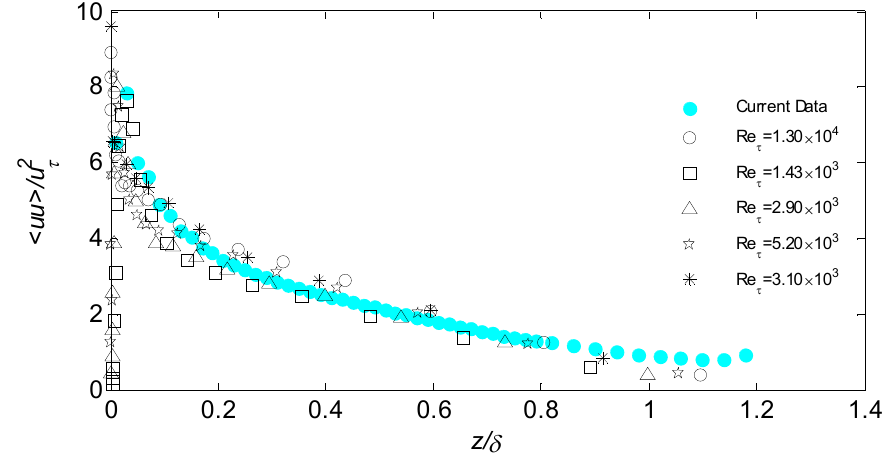
Figure 7. Comparison of uu / u 2 τ in the results of outer-scaled height simulation with the experimental data. The symbols used are the same as those used in Figure 6.